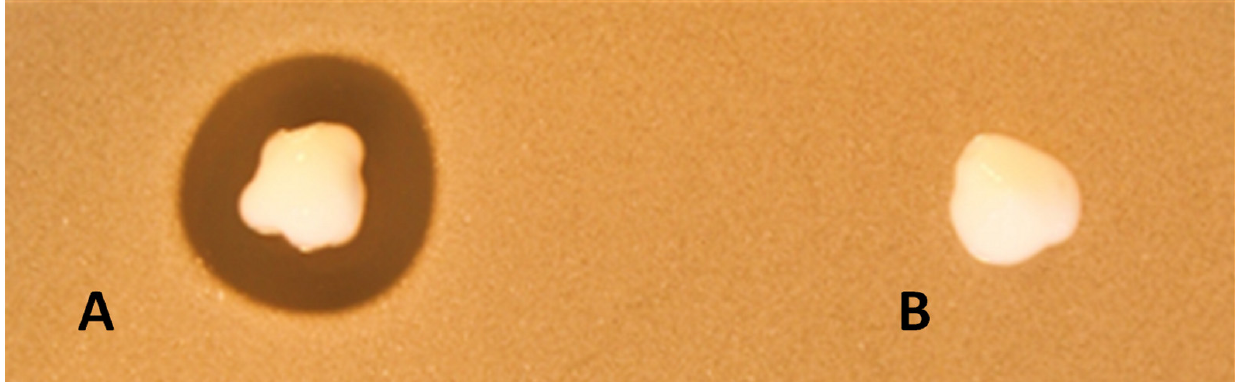
Figure 2. Assessment of antimicrobial activity of formulation containing MP1 (0.2 mg/mL), PenG (5 mg/mL) and EntEJs (1 mg/mL) dissolved in APO base cream (30% fat) ( A ). The APO base cream alone was used as a negative control ( B ). The activity was tested with a soft agar overlay assay using MRSP LMGT 4219 as an indicator strain.